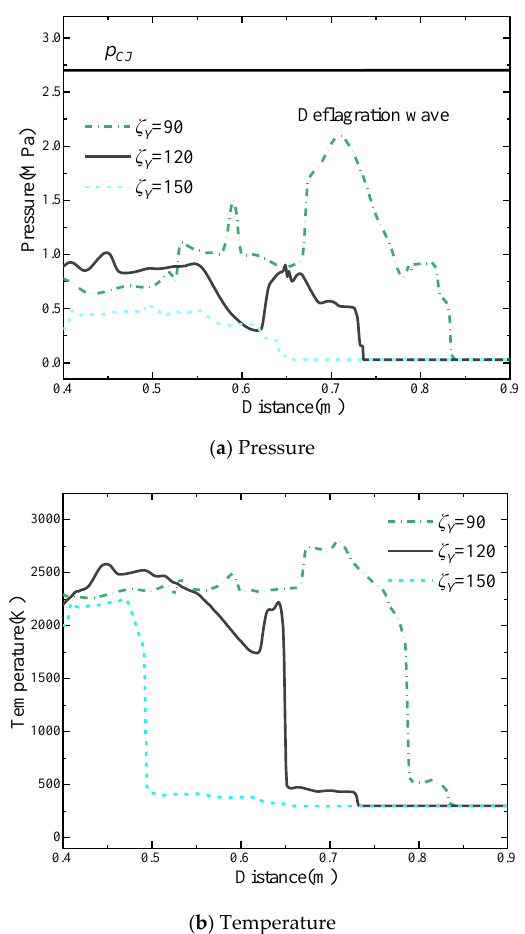
= 1.44 ms. ≥ 90 mm at t Y TDC